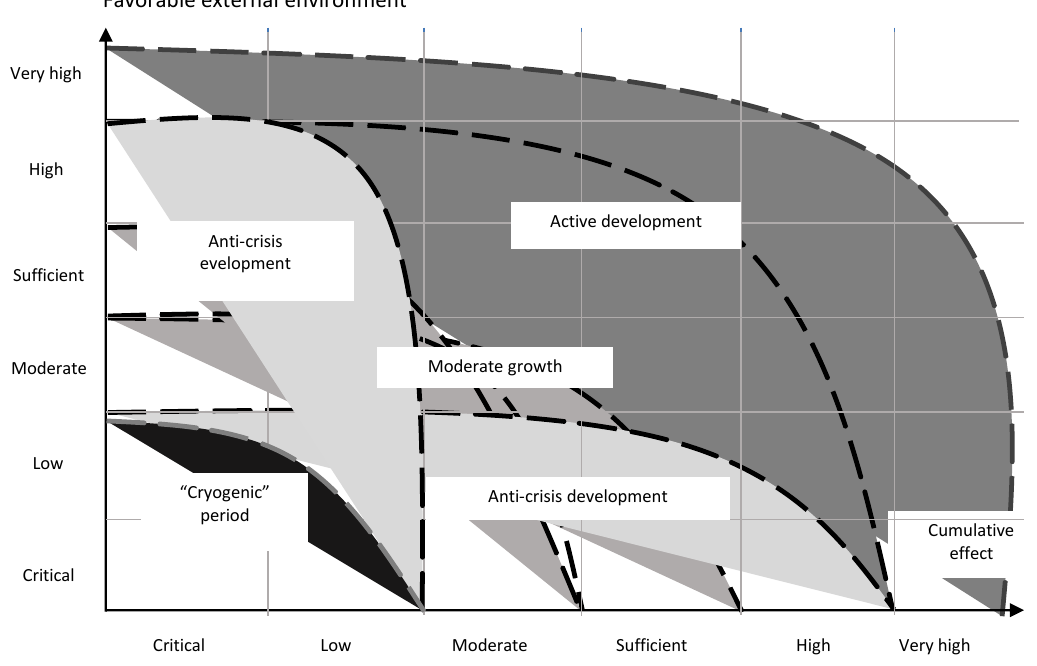
Figure 6. Matrix “internal capacity – favorable external environment” for defining the direction of technology transfer system